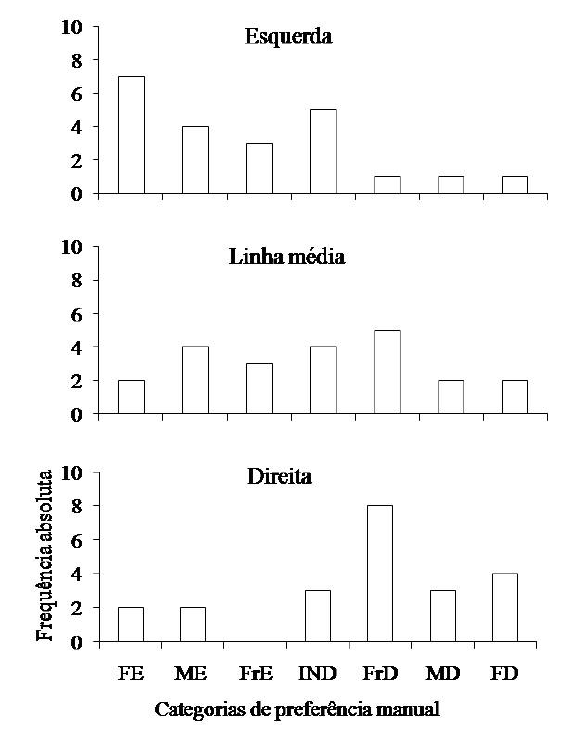
Figura 2 . Distribuição de frequências absolutas de preferência manual em função da posição de apresentação do